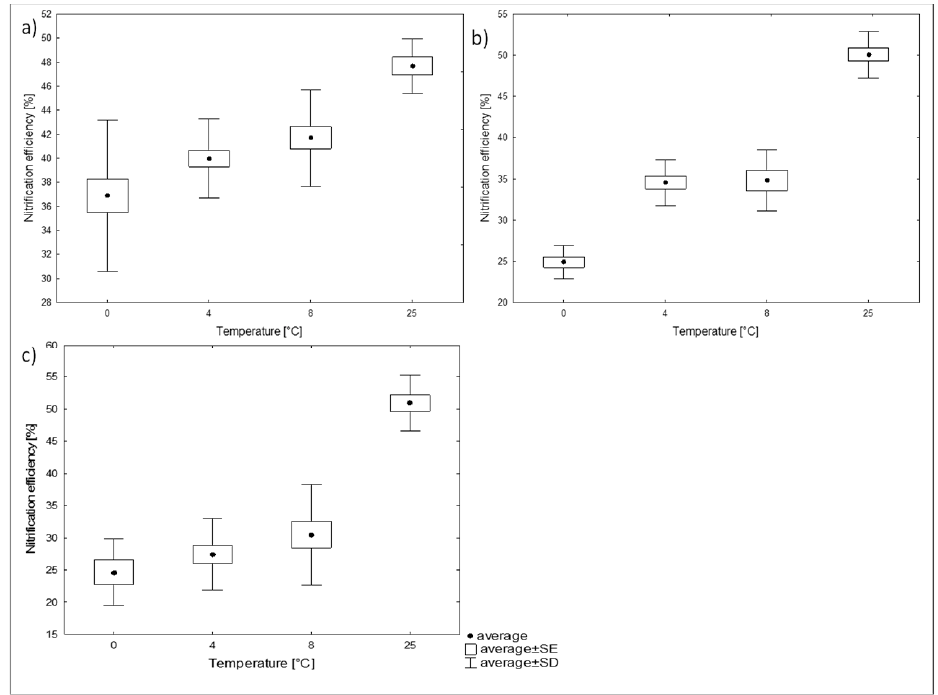
Figure 4. Influence of temperature on the nitrification efficiency in: ( a ) series 1 (C/N = 0.5 gC/gN), ( b ) series 2 (C/N = 2.5 gC/gN), ( c ) series 3 (C/N = 5.0 gC/gN).